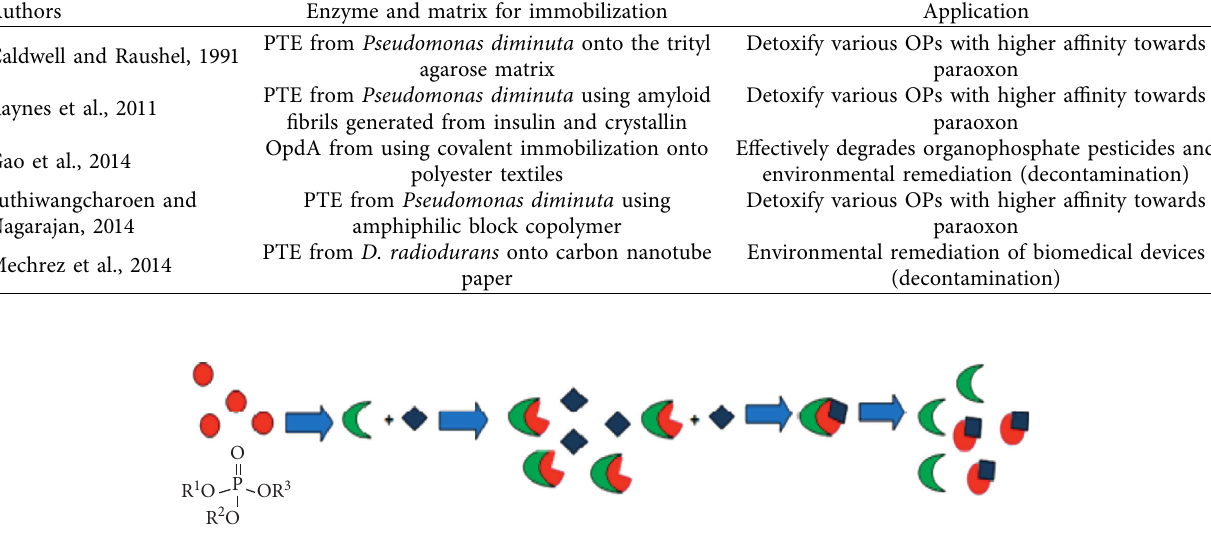
Figure 10: Schematic diagram of the pseudocatalytic mechanism. The red circle represents the nerve agent, green represents the scavenger, and dark blue represents